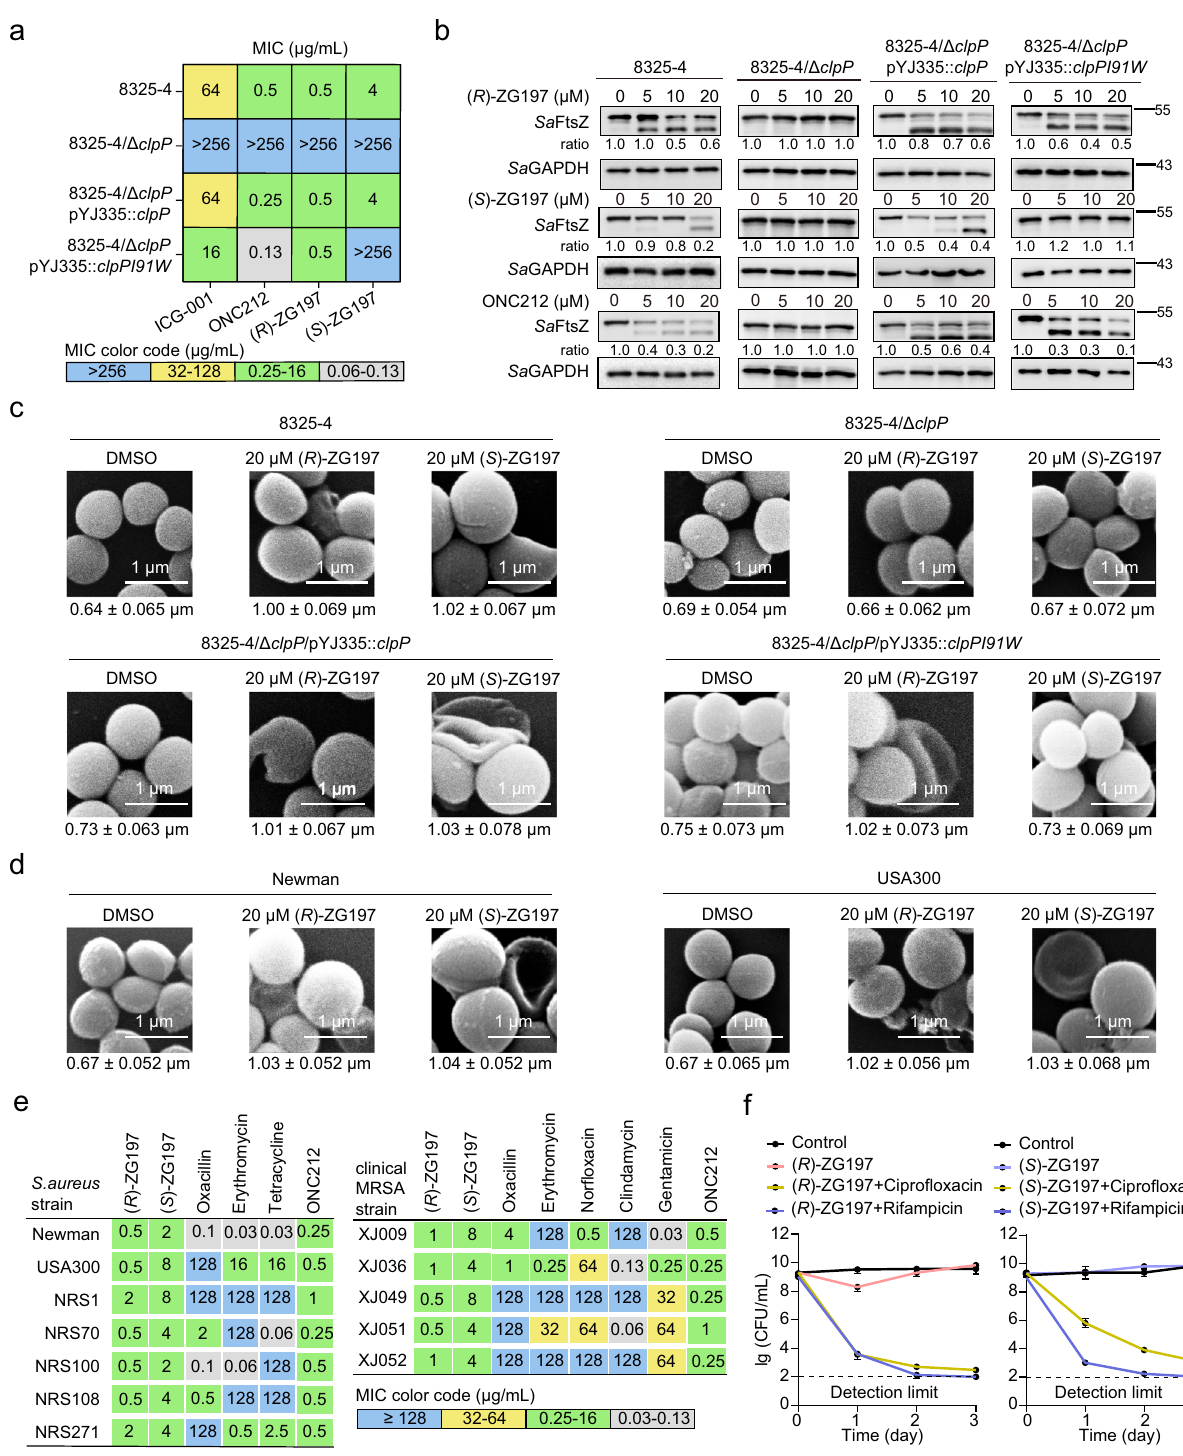
Fig.5|Targetdependencyof( R )-and( S )-ZG197 ’ antibacterialactivityincellular contexts. a Assessment of ClpP activators on the growth of S. aureus 8325-4 with genetic backgrounds of clpP , Δ clpP , and complemented clpP or I91W mutant by MICmeasurement. b Assessmentof Sa ClpPactivators ’ effectonthecellular Sa FtsZ abundanceintheintactcellsof8325-4, Δ clpP ,thecomplemented clpP and clpPI91W strains detected in Western blot. Quantitation on the band intensity of Sa FtsZ is normalized against the loading control of Sa GAPDH, and the ratio in the DMSO groupisconsideredas1.0. c RepresentativeviewsofSEMmicrographsshowingthe effects of ( R )- and ( S )-ZG197 on the cell morphology of S. aureus 8325-4 having different geneticbackgroundsof clpP , Δ clpP ,and complemented clpP or clpPI91W .